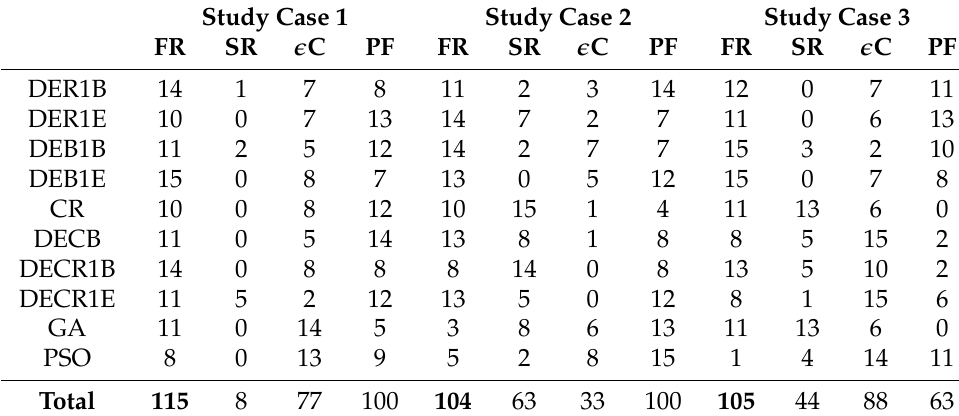
Table 7. Performance analysis of the CHTs using descriptive